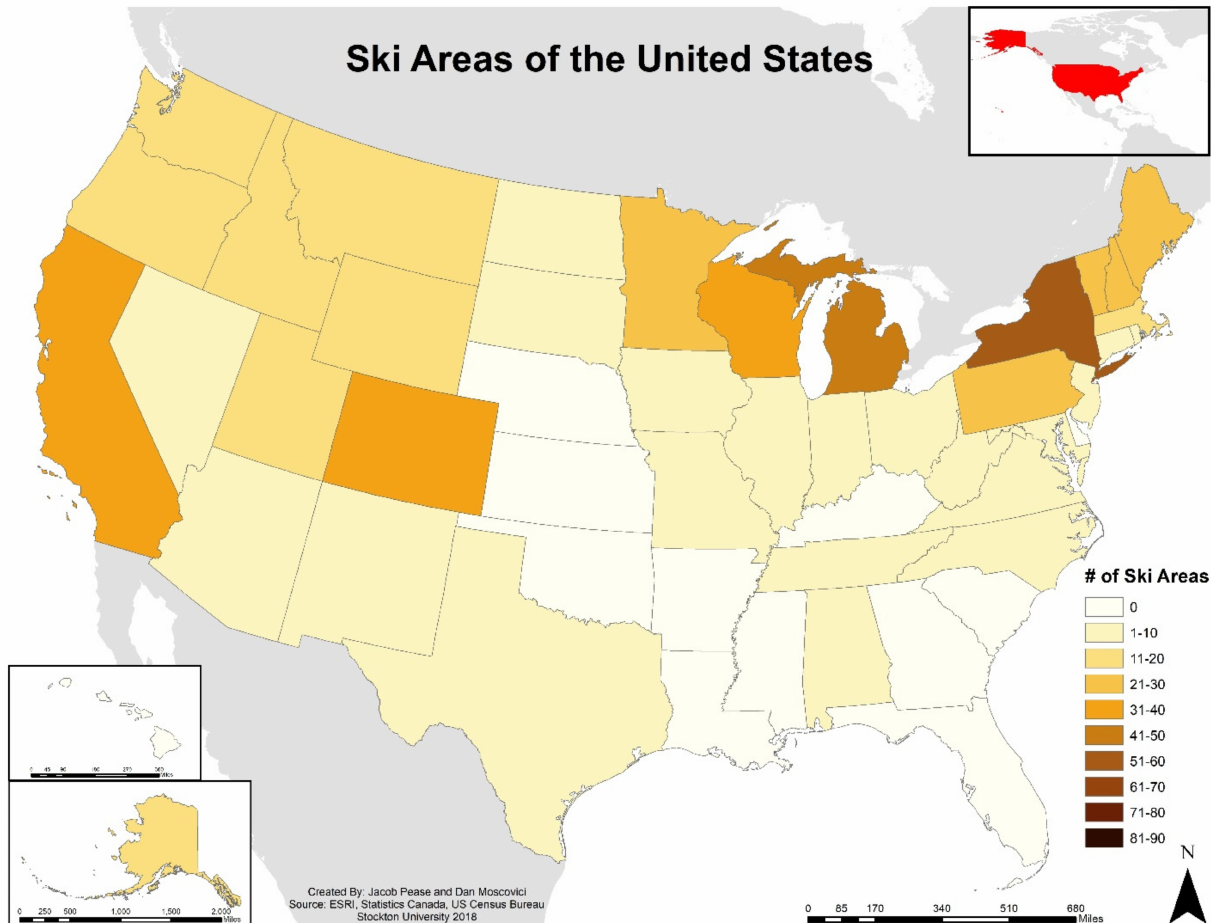
Figure 3. United States ski resorts in operation in